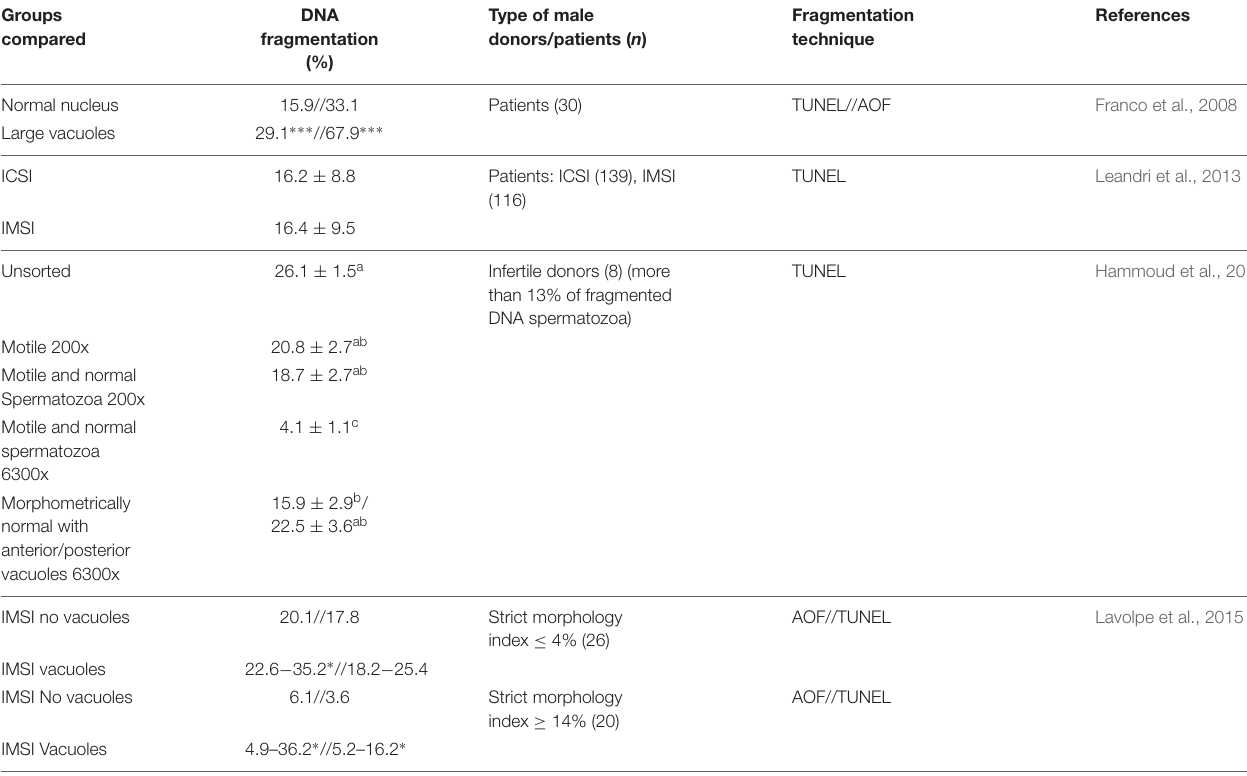
TABLE 6 | DNA fragmentation of spermatozoa selected by IMSI. Groups